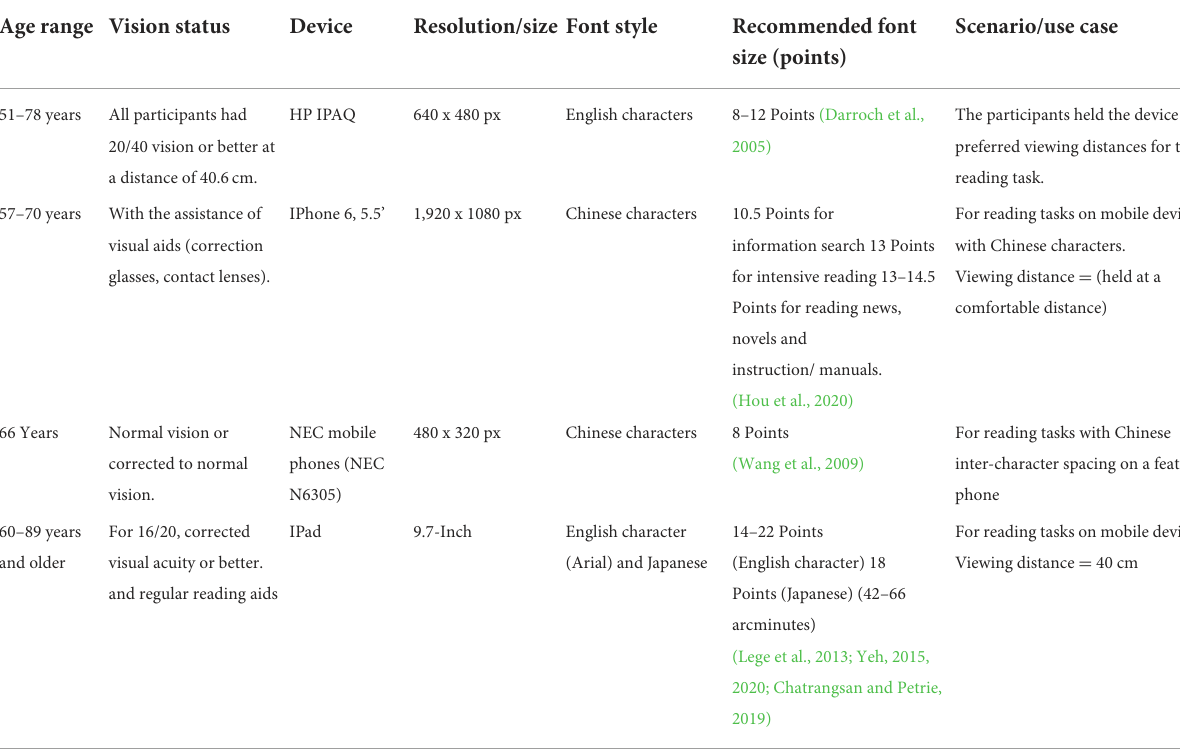
TABLE 9 Font size recommendations from selected paper and scenarios.